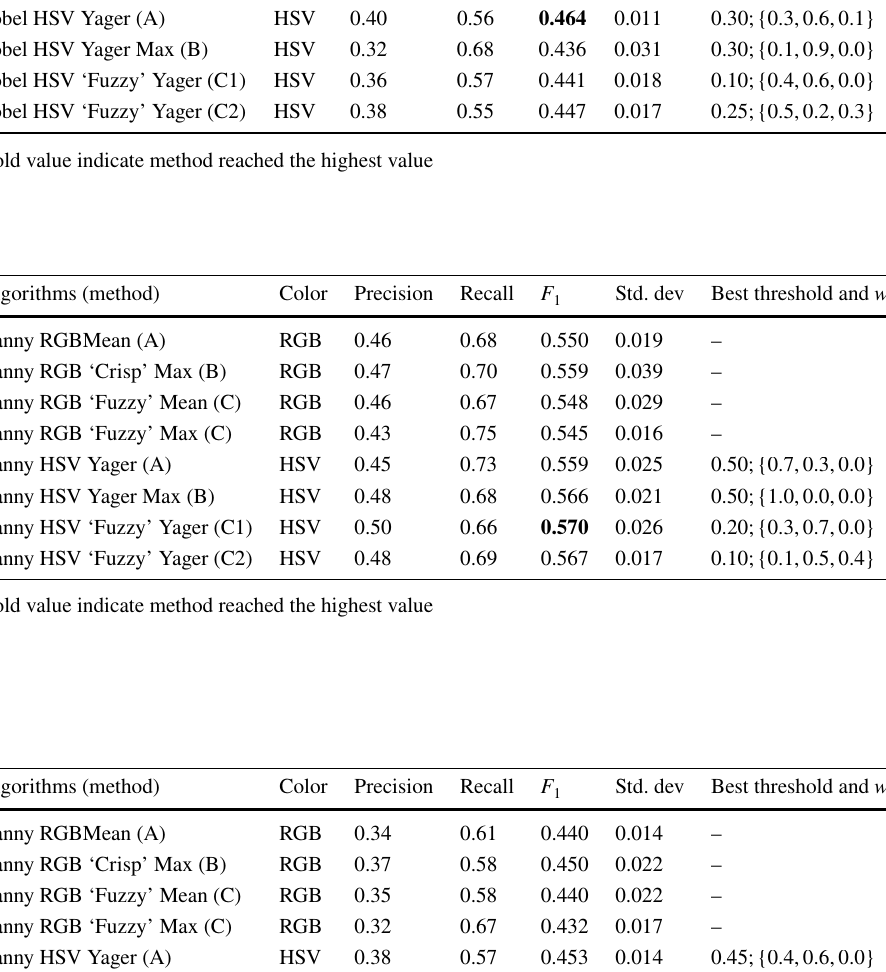
Table 2 Sobel evaluated measures for HSV and RGB algorithms (average of 10 cross-validation sets)—average human